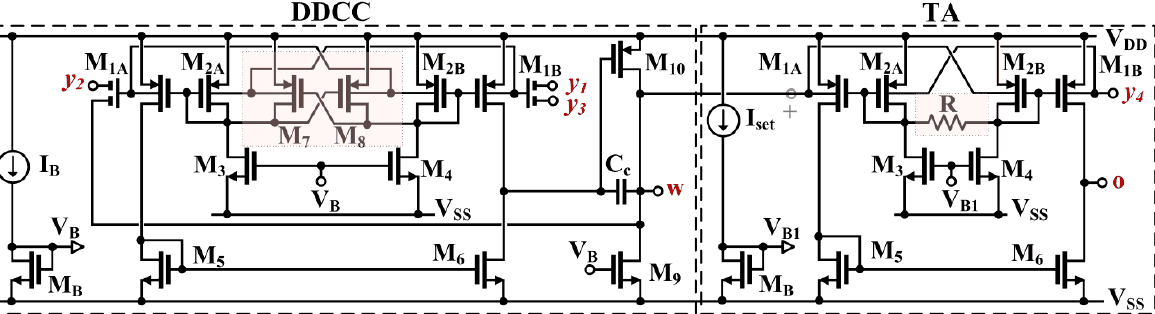
Figure 2. Proposed CMOS structure of DDTA.